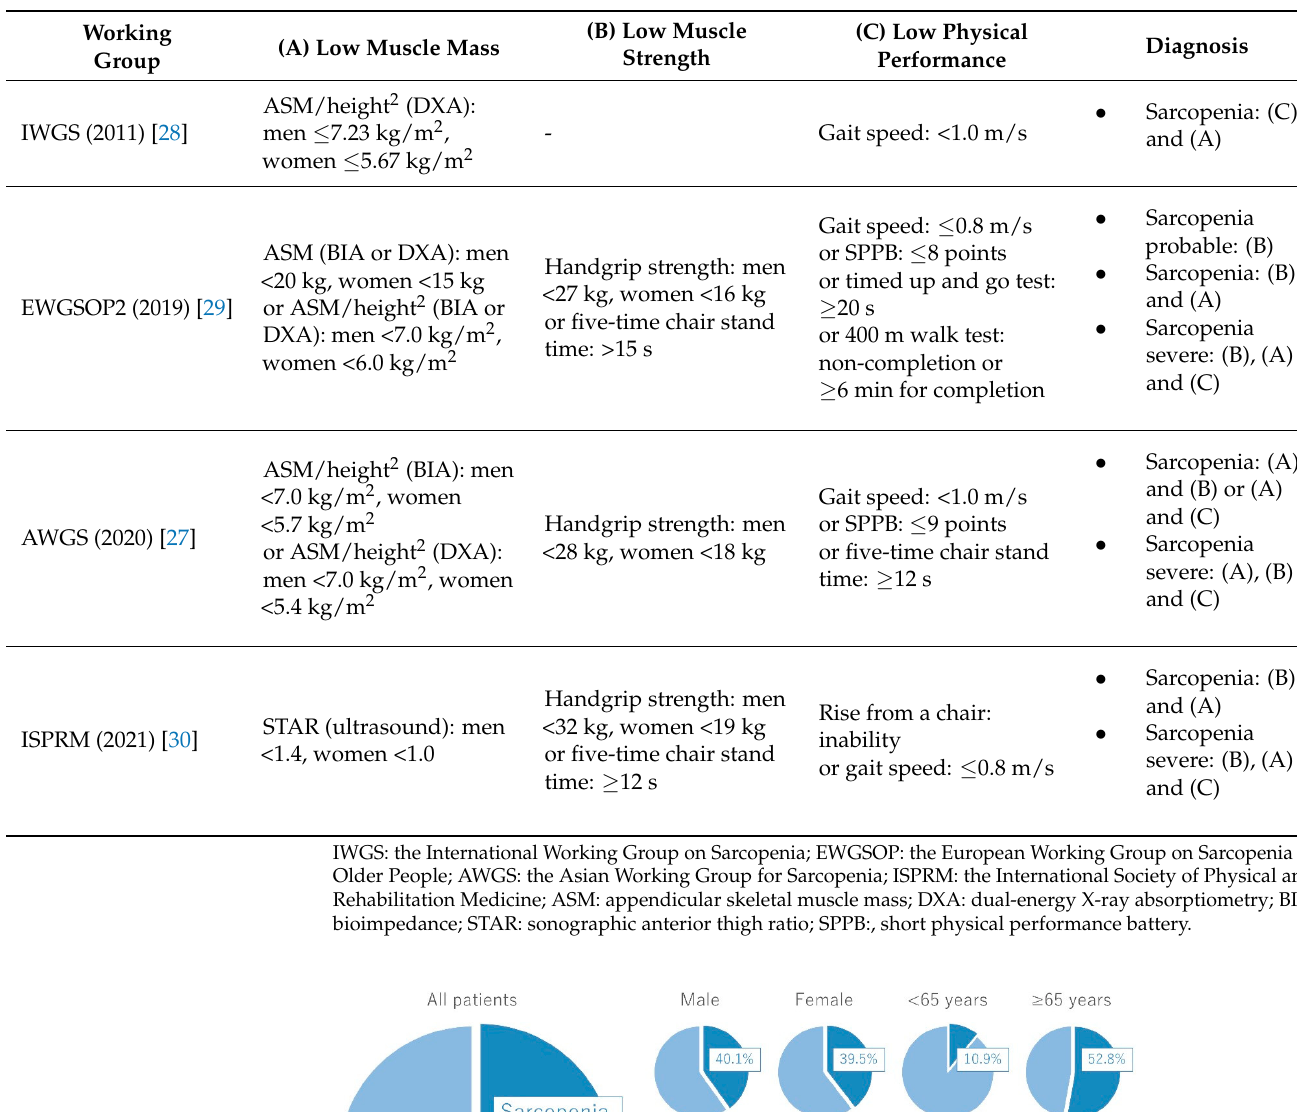
Table 2. Diagnostic criteria of sarcopenia proposed by different working groups.